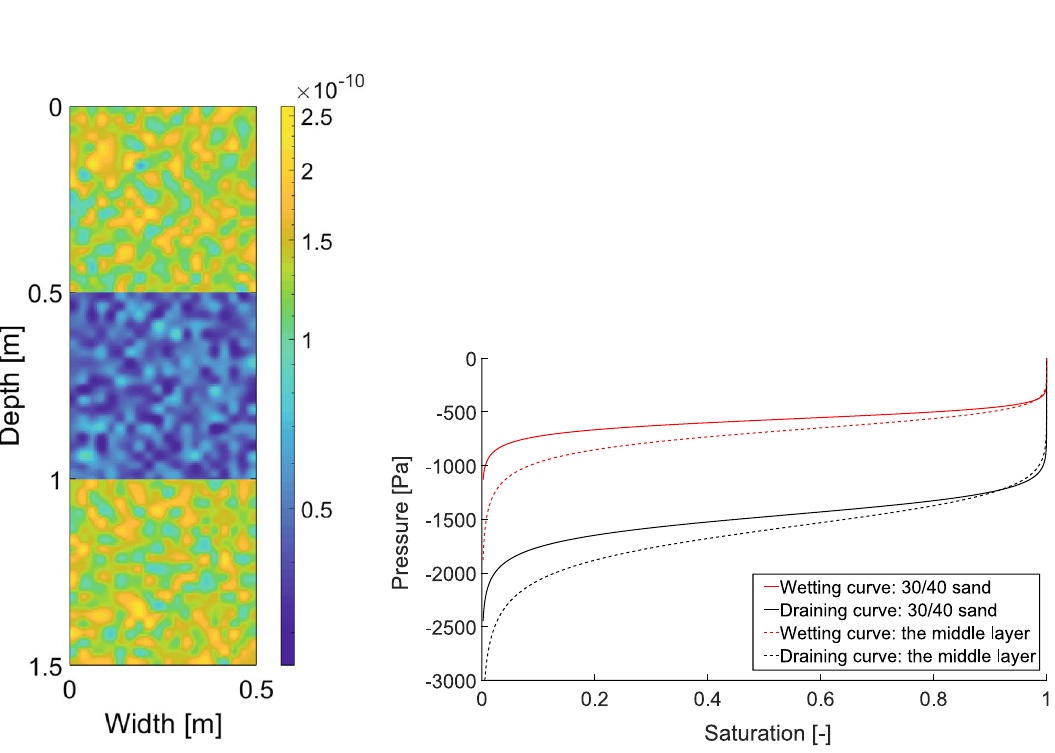
curves and the spatial distribution of intrinsic permeability are shown in Fig. 7. The horizontal arrangement of the heterogeneous layer was ignored in the simulation. Rezanezhad et al. 57 showed that stronger capillary forces in the heterogeneous layer (because of the smaller grains) were sufficient to disturb the finger flow. However, the fingering pattern re-appeared immediately in the bottom layer (see Fig. 5 in Rezanezhad et al. 57 or the supplementary video therein). We reproduce this behaviour in Fig. 8, which shows six successive snapshots of the saturation field produced by the model. Observe that the second layer wiped out the typical fingering pattern and a more diffusive regime appeared. When the fingers re-appeared in the bottom layer, there were fewer of them compared to the top layer. This is also consistent with the experimental findings 57 . If we introduced stronger horizontal spatial correlation of the intrinsic permeability in the middle layer (corresponding to the horizontal arrangement), the flow pattern would be disturbed even more. Here, we only wanted to show that this effect can be reproduced by a small change in the retention curve.